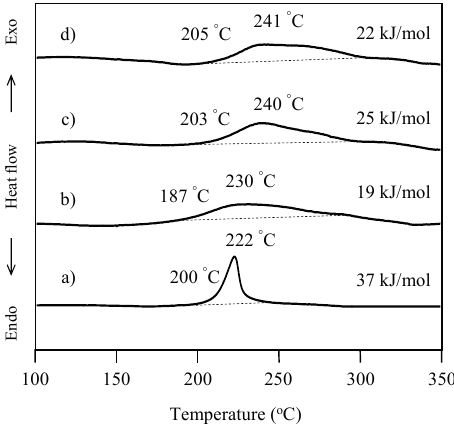
Figure 7. DSC thermogrmas of P-a (a), oligo(P-4va) (b), P(P-4va/St) (c), and P(P-4va/MMA) (d). The exothermic amounts were calculated on the basis of the benzoxazine monomeric unit.